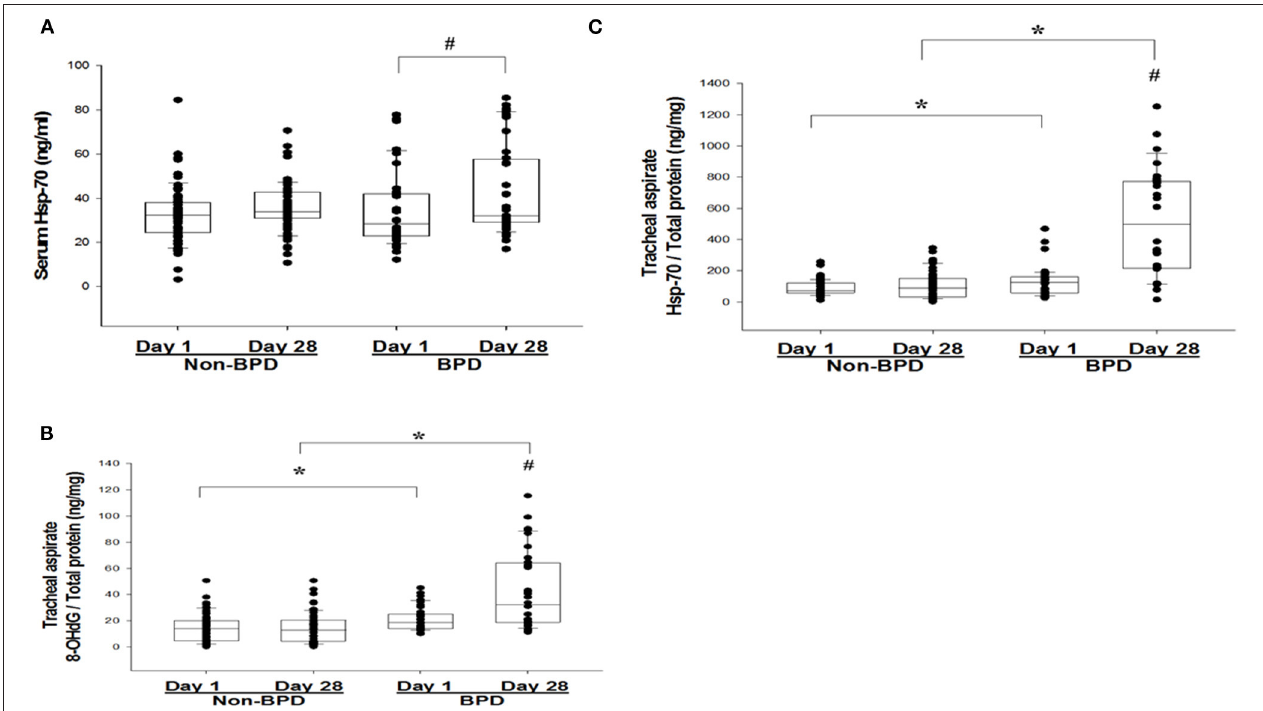
FIGURE 1 | (A) Serum heat shock protein-70 (Hsp-70) on post-natal days 1 and 28 from very low–birth weight (VLBW) infants who developed bronchopulmonary dysplasia (BPD). (B) 8-hydroxy-2 ′ -deoxyguanosine (8-OHdG) and (C) Hsp-70 from tracheal aspirates (TAs) on post-natal days 1 and 28 from VLBW infants, according to the absence or presence of BPD. The box plots show the 25th and 75th percentiles. # P < 0.05 between Day 1 and Day 28. * P < 0.05 between the BPD and non-BPD